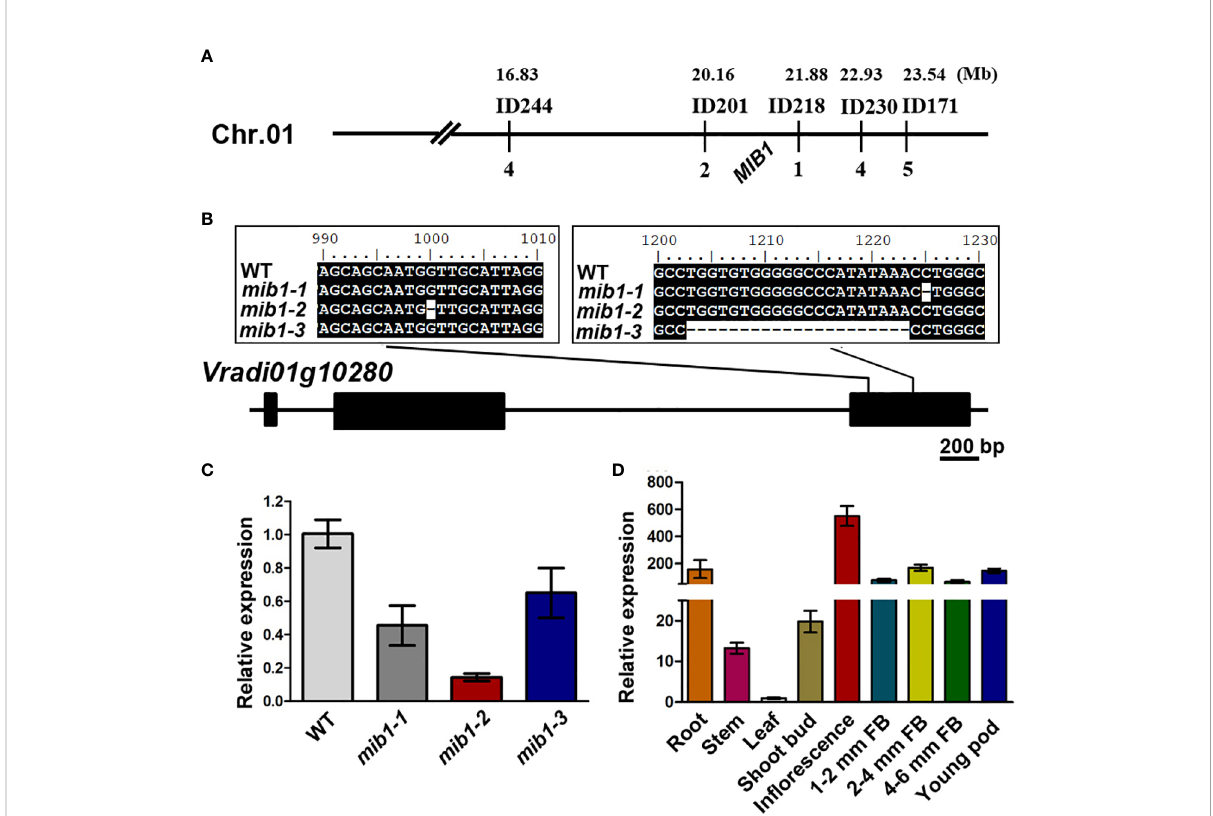
FIGURE 3 Map-based cloning of MIB1 . (A) Genetic map of MIB1 in mungbean. (B) Mutations in the open reading frame of Vradi01g10280 . Numbers up the sequence indicate the position on the open reading frame. (C) Analysis of MIB1 expression in shoot buds of WT and mib1 mutant by qRT-PCR. (D) Relative expression level of MIB1 in different tissues of